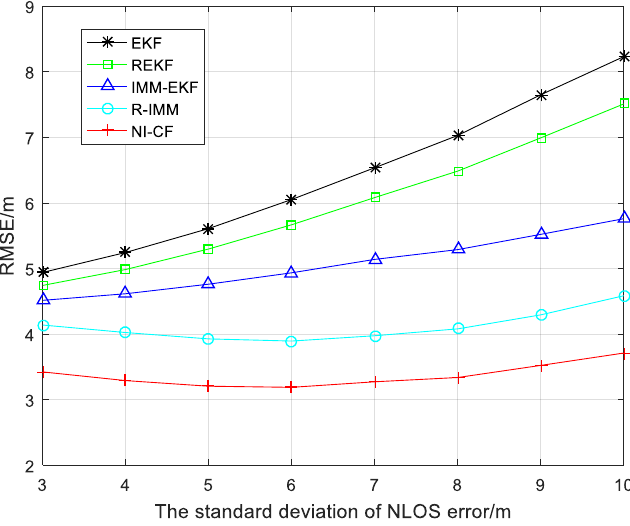
Figure 5. The RMSE versus the standard deviation of NLOS error.